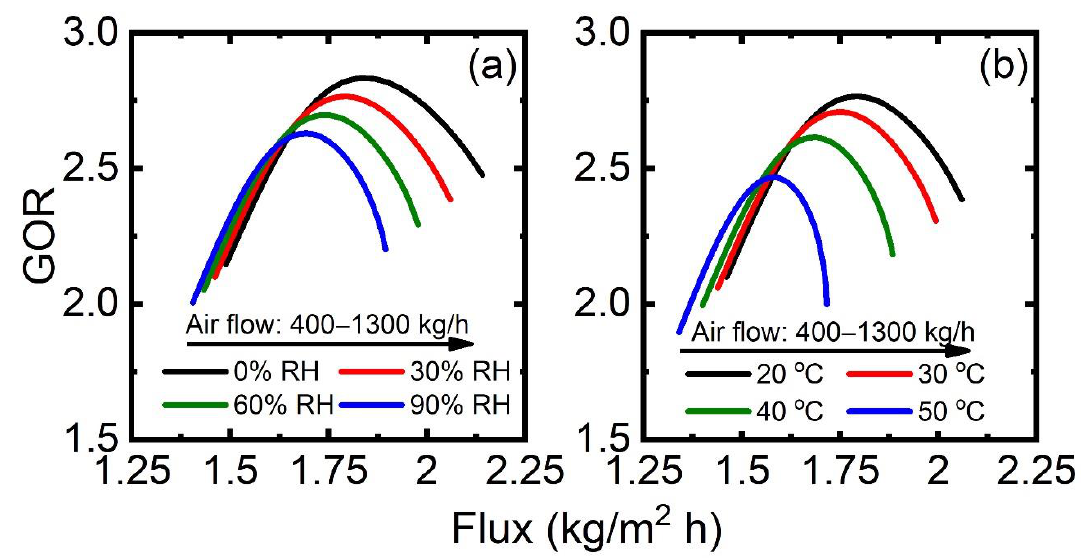
Figure 8. GOR – flux performance for permeate conditions in SGMD with varying ( a ) airflow rate of 400 – 1300 kg/h and ( b ) RH of 0 – 90%. Note that GOR and flux are calculated from the SGMD-based desalination process at each condition.